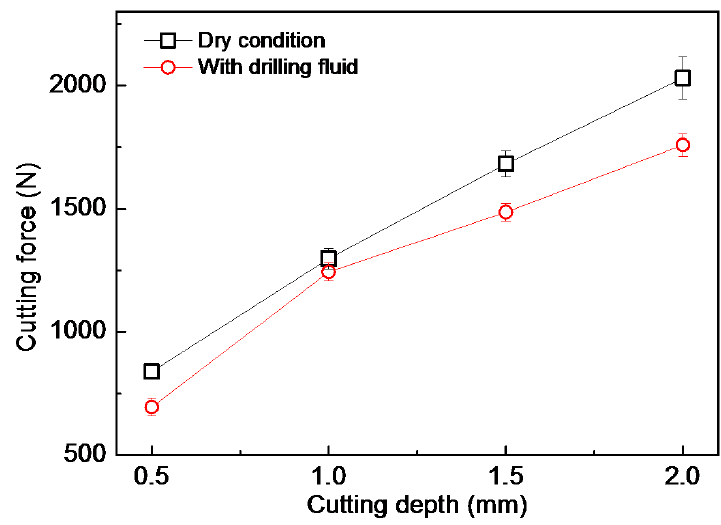
Figure 7. Change of cutting force with cutting depth.